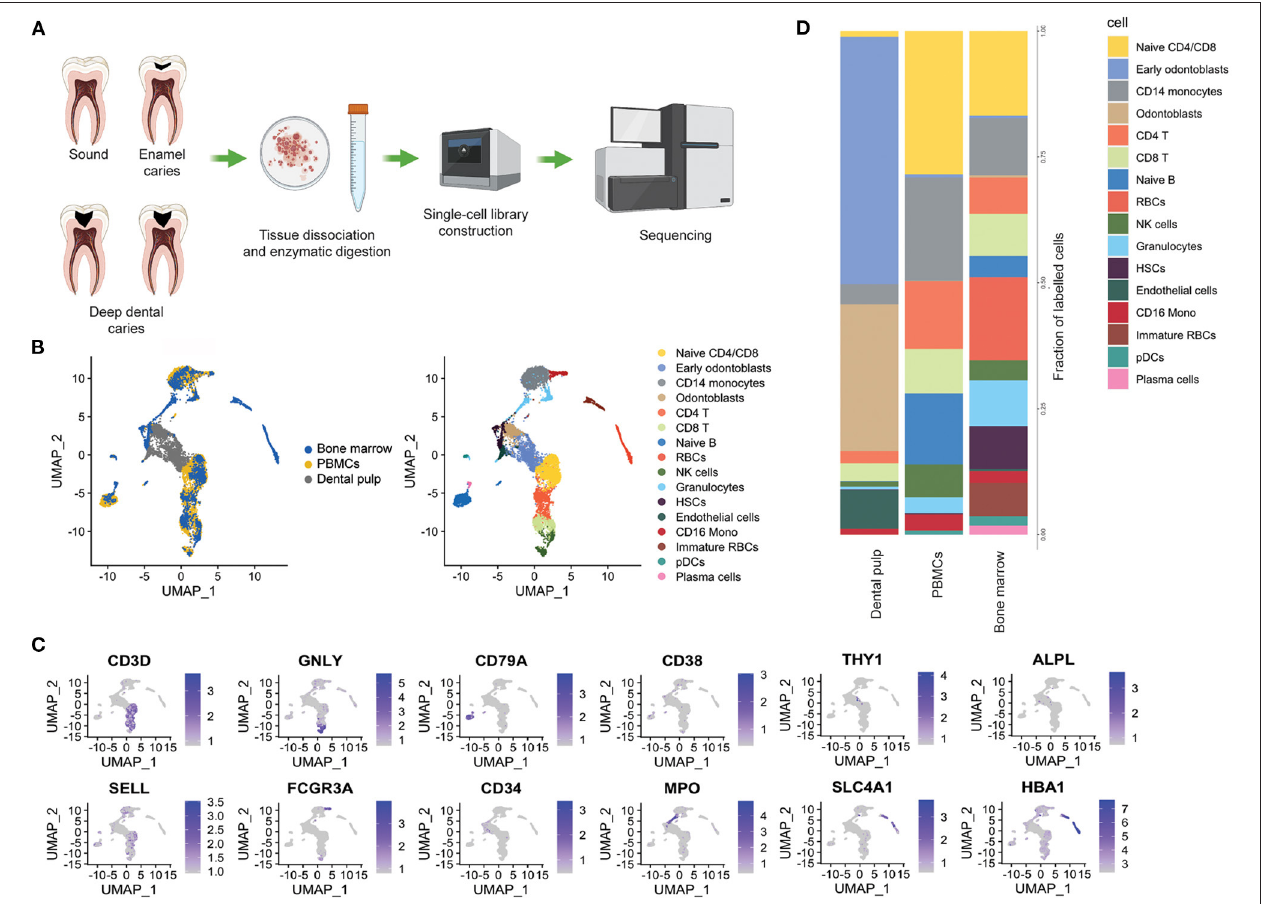
FIGURE 1 | Tissue distribution of stromal and immune cells in the dental pulp. (A) Schematic representation of experimental design. (B) Integrated UMAP from the healthy bone marrow and PBMCs (from publicly available data) and dental pulp samples (sound and enamel caries, from this study). (C) Normalized expression levels of the key maker genes used for cell type identification. (D) Stacked bar plots showing the proportion of cell type within dental pulps, PBMCs and bone